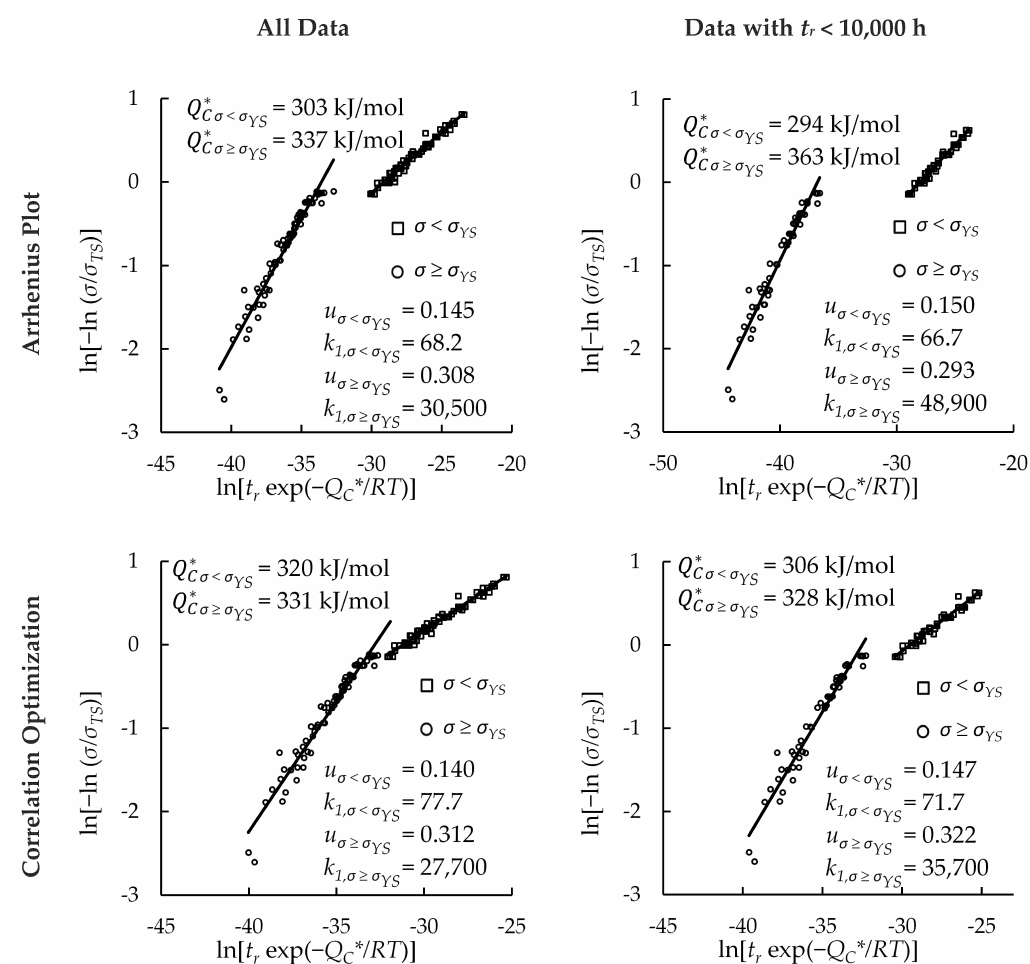
Figure A6. The effect of region-splitting on the goodness of fit of Wilshire plots for Sanicro 25.